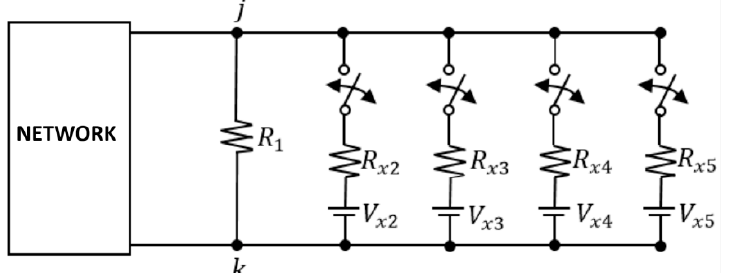
Figure 5. Circuital representation of the piecewise approximation for the characteristic curve of a nonlinear element presented in Figure 5 [11].